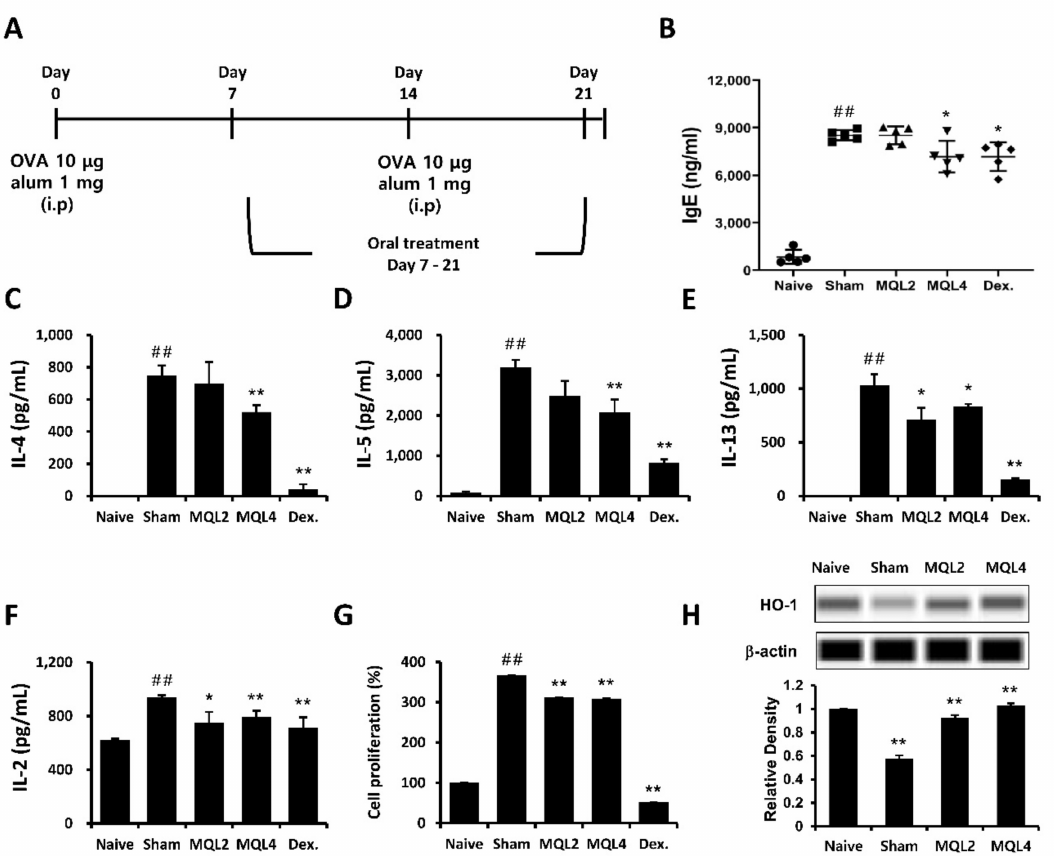
Figure 1. Effects of MQL on the OVA-induced allergic mouse model. ( A ) Experimental schedule of the OVA-induced allergic mouse model. Allergic immune responses in BALB/c mice were induced by i.p. injection of OVA (10 µ g) with alum (1 mg) on days 7 and 14. MQL was orally administered daily from days 7 to 21. ( B ) The level of serum IgE was analyzed using ELISA. ( C – F ) Splenocytes were seeded to 5 × 10 6 cells/mL and cultured in the presence of OVA (100 µ g/mL) for 72 h. ( C ) IL-4, ( D ) IL-5, ( E ) IL-13, and ( F ) IL-2 cytokines in culture supernatant of splenocytes were measured using ELISA. ( G ) Cell proliferation was measured using MTT assay, and ( H ) HO-1 expression was detected in splenocytes of each group using Western blot. Results are shown as mean ± SD. ## p < 0.01, between the naïve and sham groups, * p < 0.05, ** p < 0.01, between the MQL-treated and sham